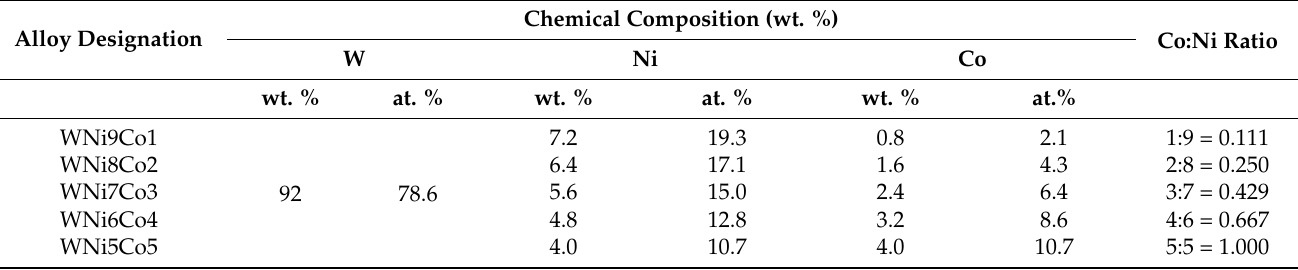
Table 1. Chemical composition of the